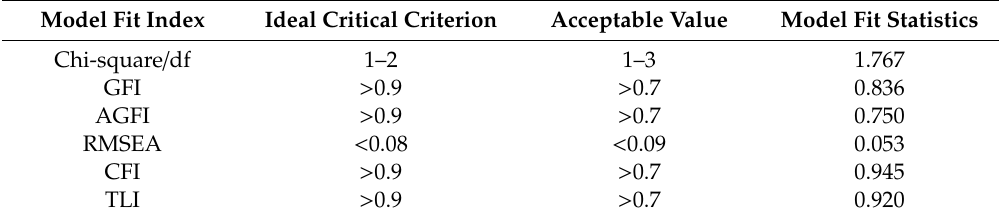
Table 4. Model fit indexes.